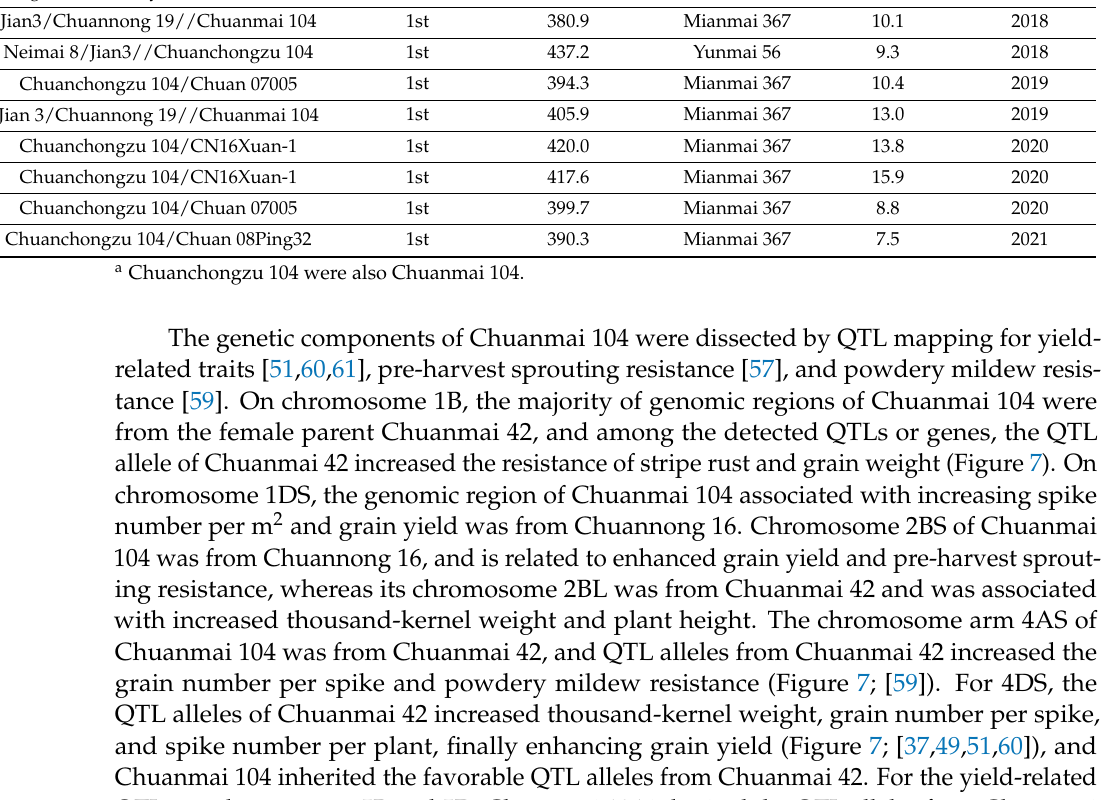
Table 4. Cultivars released from the cross involving Chuanmai 42 in southwestern China.